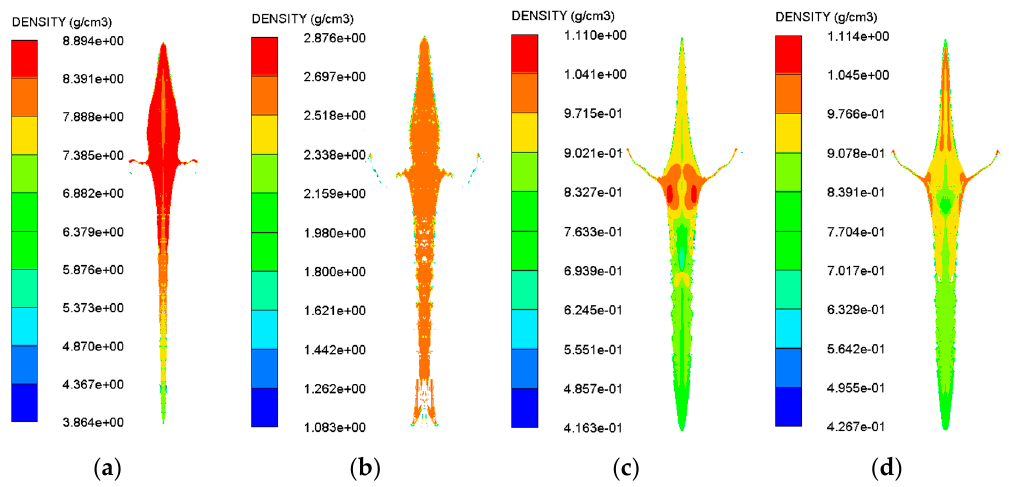
Figure 5. The jet density state at the distance of 3 CD for different liner materials: ( a ) copper; ( b ) floatglass; ( c ) Lucite; and ( d ) Plexiglas.